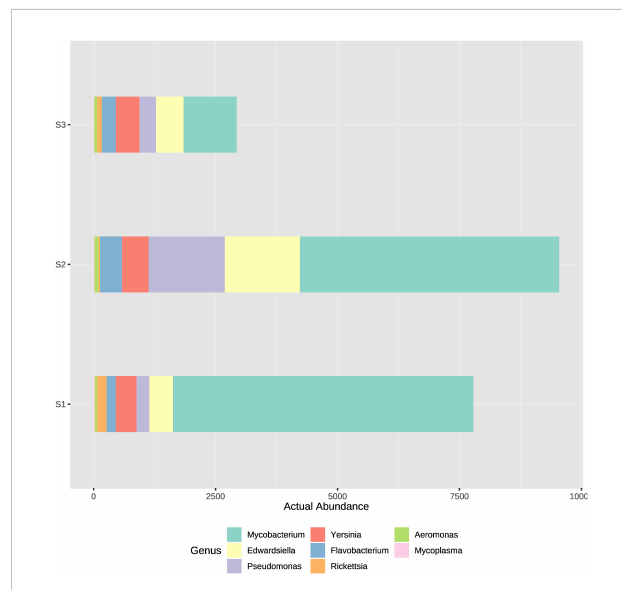
FIGURE 8 Actual abundances of ASVs corresponding to several potentially pathogenic bacterial genera. Each plot bar correspond to the ASVs obtained at high- (S1), medium- (S2) and low-density (S3)